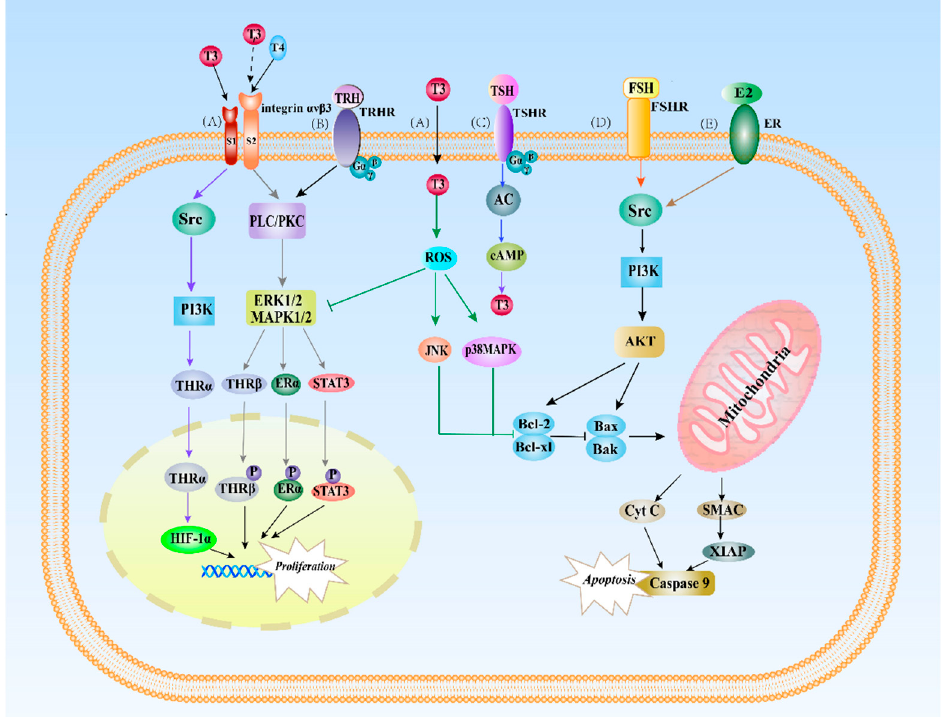
Figure 2. Nongenomic actions of TH and reproductive hormones in the female reproductive system. (A) The nongenomic effects of THs are initiated by integrin α V β 3 in the plasma membrane. T3 interacts with the S1 domain of integrin α V β 3 and activates the PI3K signaling pathway via Src kinase, resulting in the transport of THR α from the cytoplasm to the nucleus and increasing HIF-1 α expression. T4 and T3 also interact with the S2 domain of integrin α V β 3 to activate ERK1/2 signaling, leading to phosphorylation and nuclear localization of THR β , ER α , and STAT3 to promote cell proliferation. T3 promotes a local proinflammatory environment and stimulates ROS generation to activate JNK and p38MAPK, enhancing ectopic cell proliferation and angiogenesis; (B) TRH stimulates the phospholipase C (PLC)/protein kinase C (PKC)-dependent pathway to activate ERK signaling and promotes prolactin gene expression by activating Gq protein coupled with the TRH receptor. (C) TSH binds to TSHR, promoting the synthesis and release of TH through the cAMP cascade effect; (D) FSH binds to FSHR and increases the levels of the antiapoptotic protein XIAP and caspase-9 by activating Src and via the PI3K/Akt signaling pathway, ultimately inhibiting apoptosis; (E) ER also activates Src and PI3K/Akt signaling pathways to promote cell proliferation and anti-apoptosis in the female reproductive system. Abbreviations: Src, proto-oncogene tyrosine-protein kinase; PI3K, phosphatidylinositol-3-kinase; PLC, phosphorylase C; PKC, protein kinase c; ERK, extracellular-signal-regulated kinases 1/2; MAPK, mitogen-activated protein kinase; STAT3, signal transducer and activator of transcription 3; ROS, reactive oxygen species; JNK, c-Jun N-terminal kinase; AKT (protein kinase B); cAMP, cyclic adenosine monophosphate; Bcl-2, B-cell lymphoma-2 Bax, Bcl2-associated X protein; Bak, Bcl2 antagonist/killer 1; Cyt C, cytochrome C; SMAC, second mitochondria-derived activator of caspase; XIAP, X-linked inhibitor of apoptosis protein. ↓ , Stimulatory modification; ⊥ , Inibitory modification. Different colors indicate signaling pathways validated in different literatures.